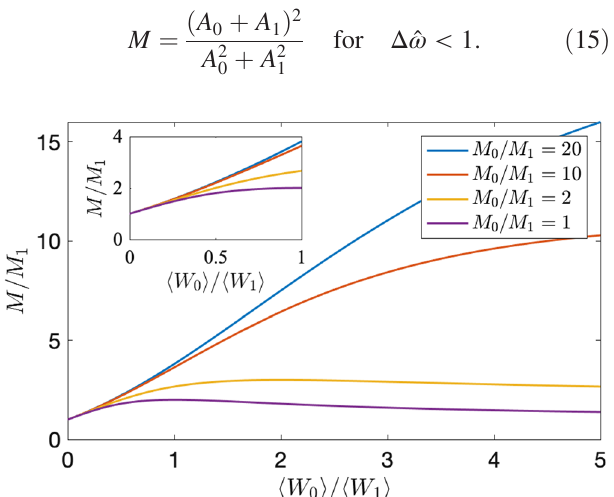
FIG. 3. Total mode number in Eq. (13) relative to the number of seed modes M 1 as a function of the relative SASE energy. As the SASE energy grows compared to the seed, the number of modes also grows until M ≈ M 0 .